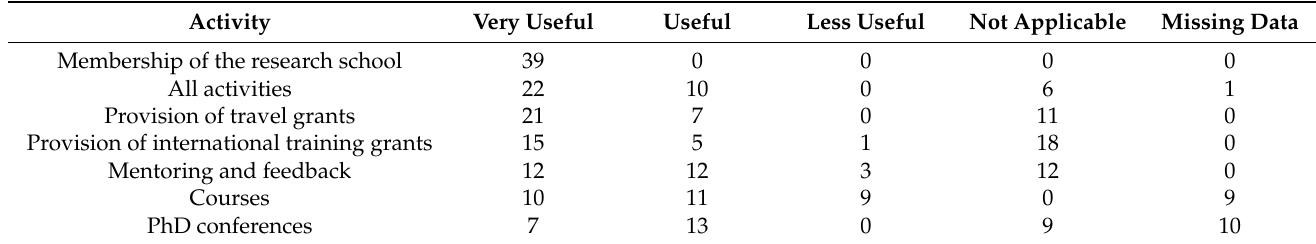
Table 2. Usefulness of activities evaluated by PhD alumni of the Norwegian Research School of Global Health (N = 39).